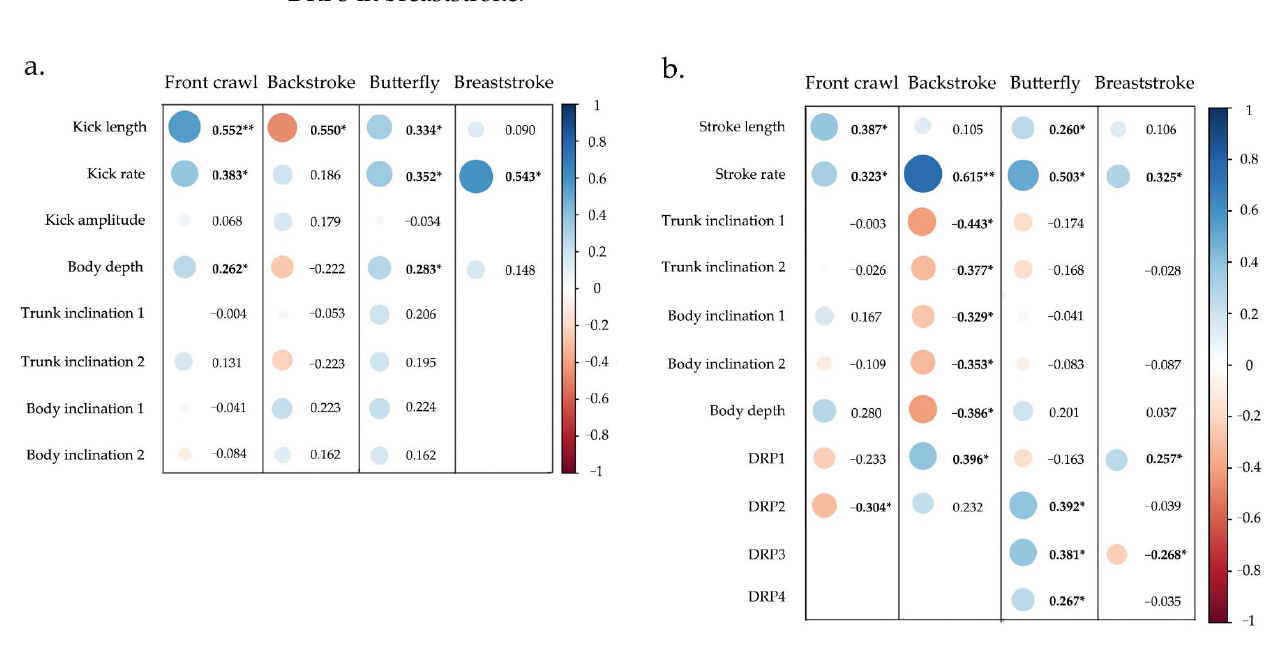
Figure 2. Relationships between the kinematic, segmental and coordination variables with average velocity of the competitive swimmers in the pre-transition ( a ) and transition ( b ) of the push start. Note: * denotes correlations at a p < 0.05 level.